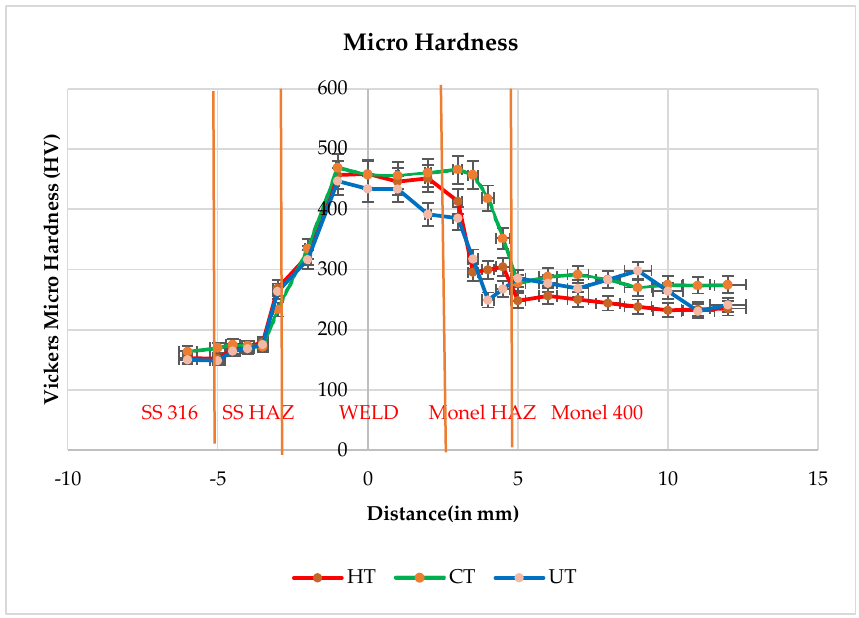
Figure 4. Micro hardness mapping of zones for HT, CT, and UT.